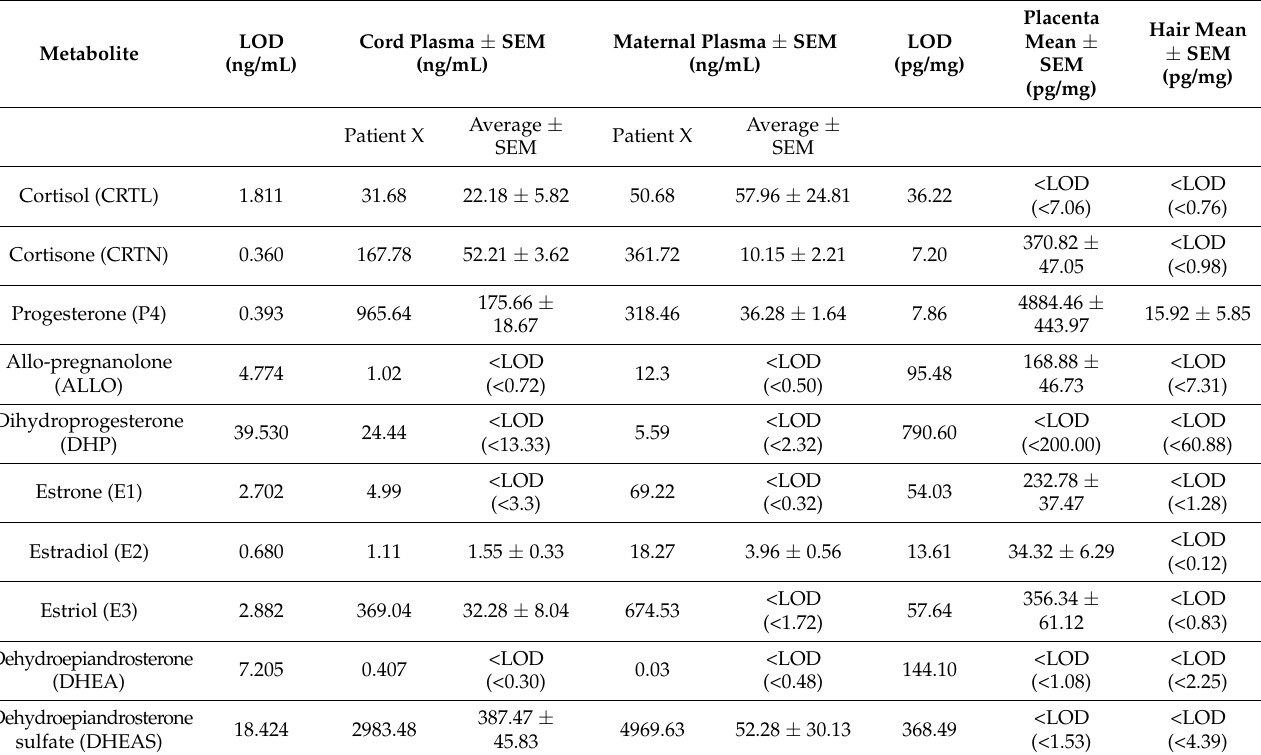
Table 2. Steroid metabolite concentrations in maternal and fetal